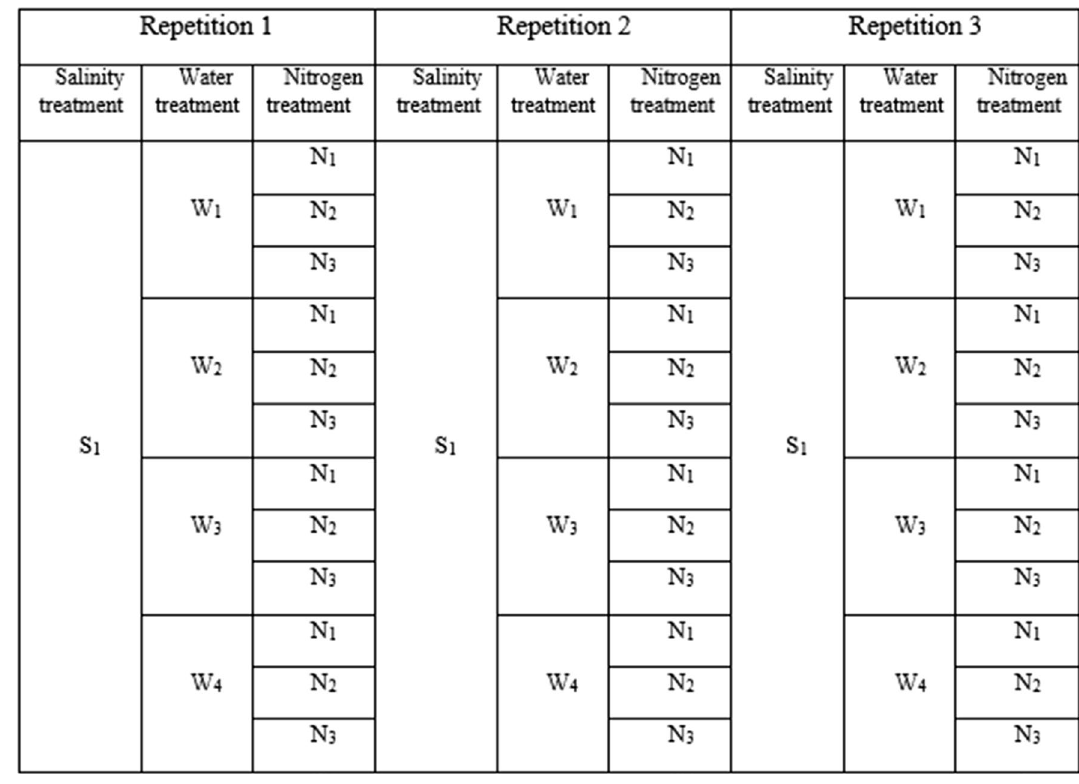
Fig. 3 Schematic map of relationship between salinity treatment 1 and other water and Nitrogen